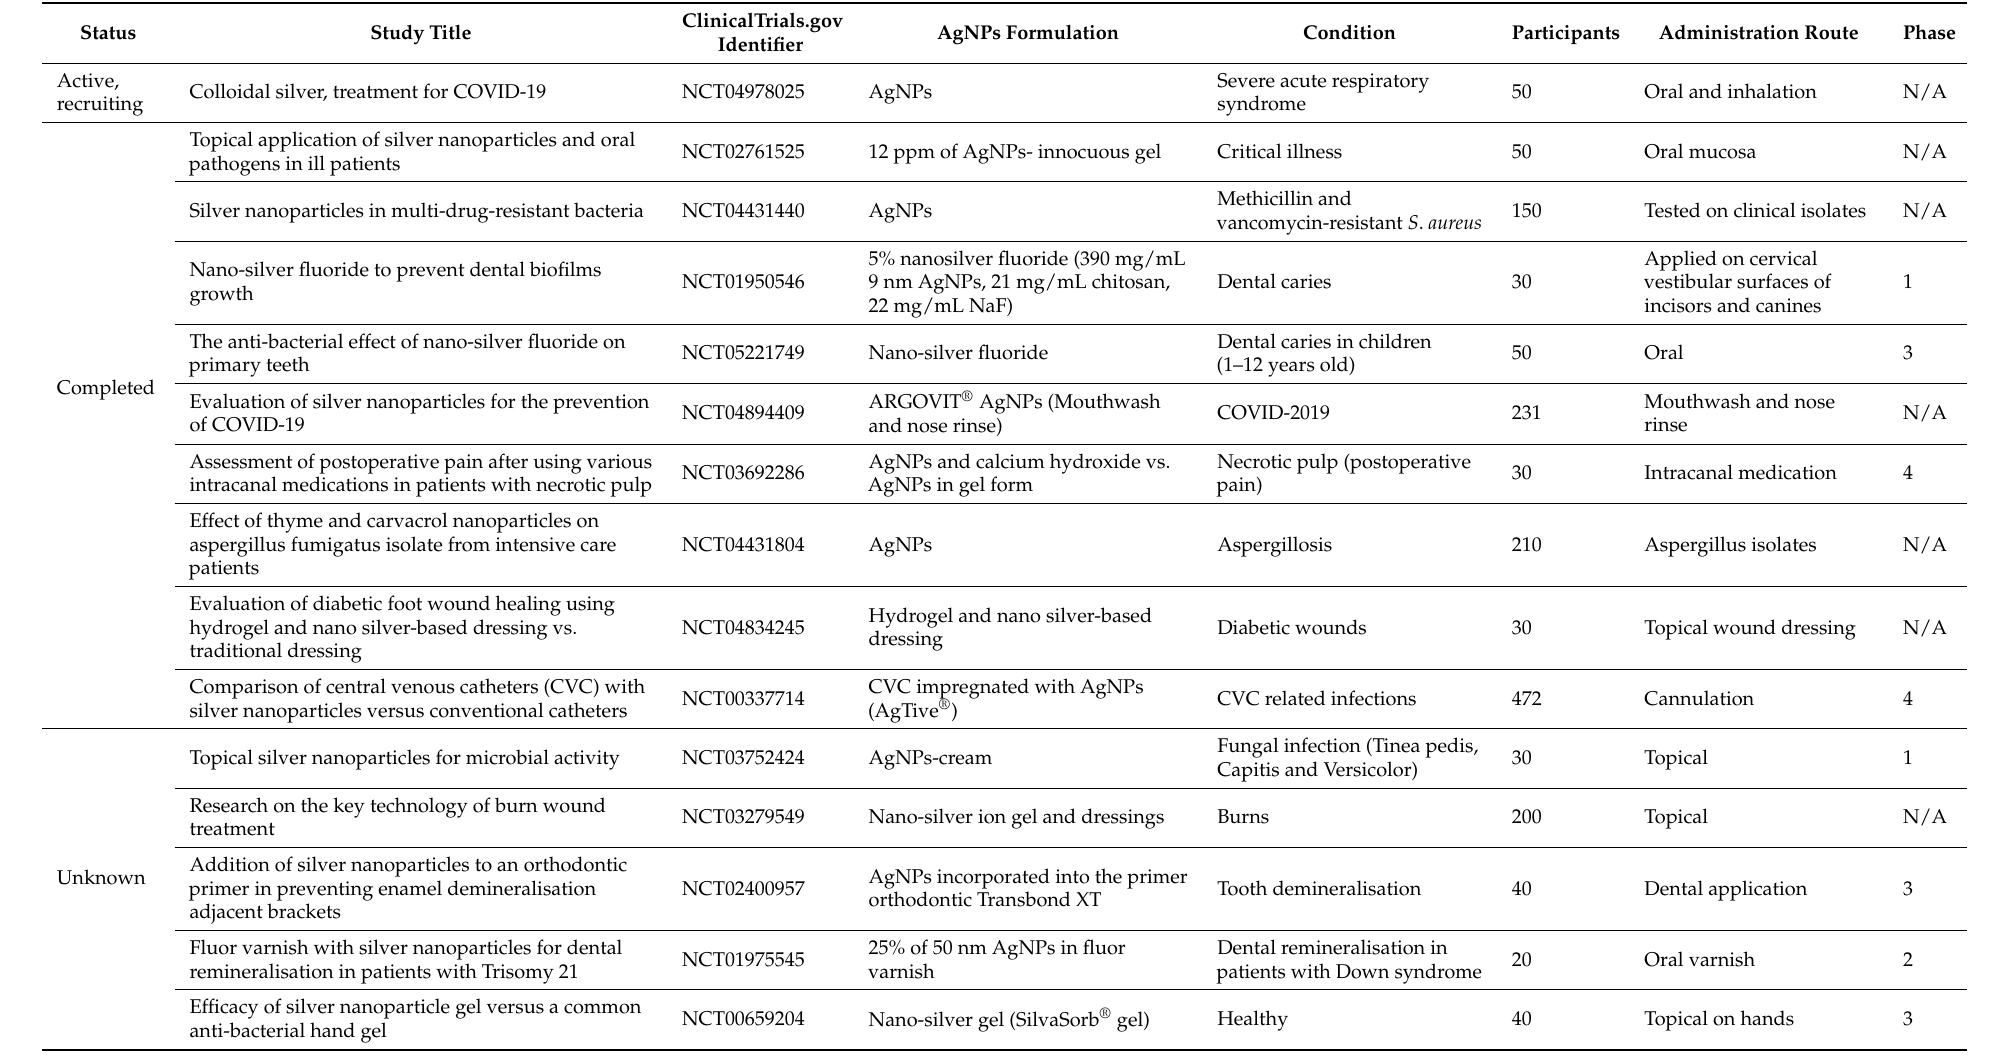
Table 7. AgNPs-based products approved by FDA for clinical